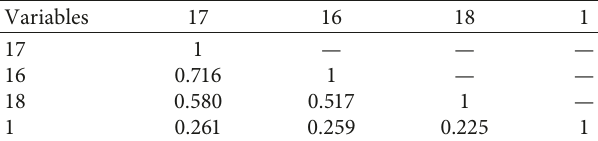
Table 8: Pearson correlation coefficient matrix for the variables in factor